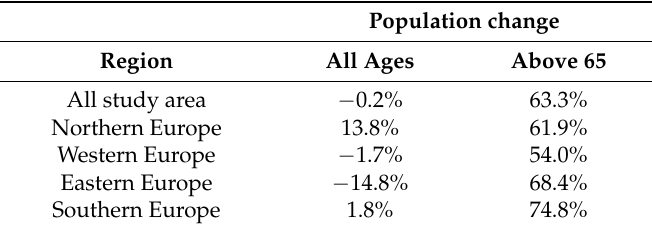
Table 2. Changes in population in Europe and the four sub-regions